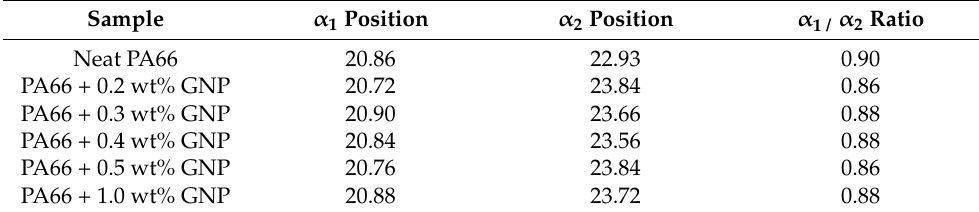
Figure 4. Diffraction patterns of neat PA66 and PA66/GNP nanocomposites after elongation at break. Table 5. α 1 and α 2 peak positions of neat PA66 and its GNP-based nanocomposites.